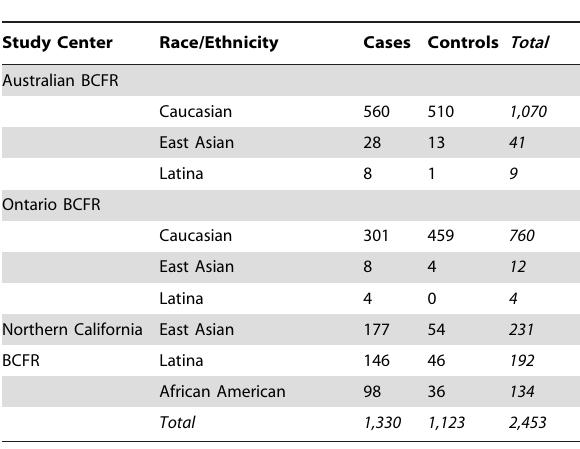
Table 4. Distribution of patients and controls by study center and by race/ethnicity in the